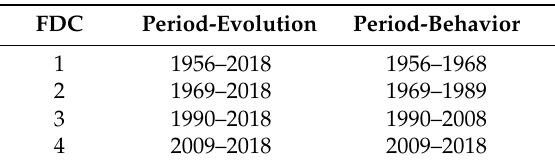
Table 5. Periods of record for FDCs.